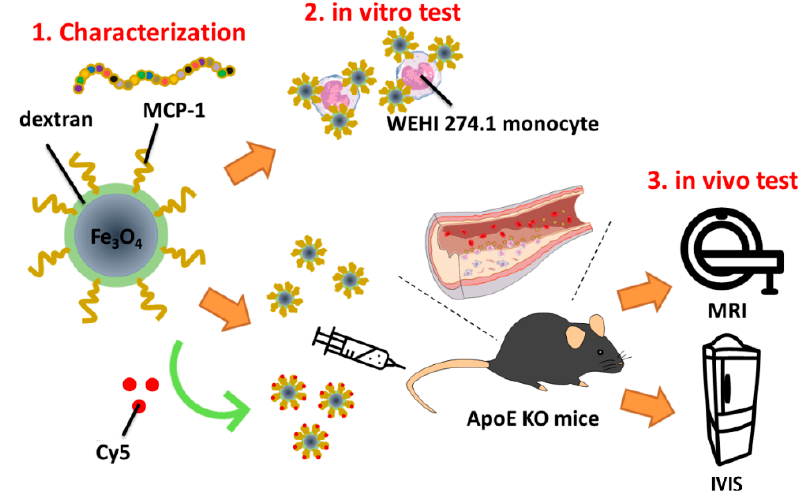
Figure 1. Scheme of the experiment.